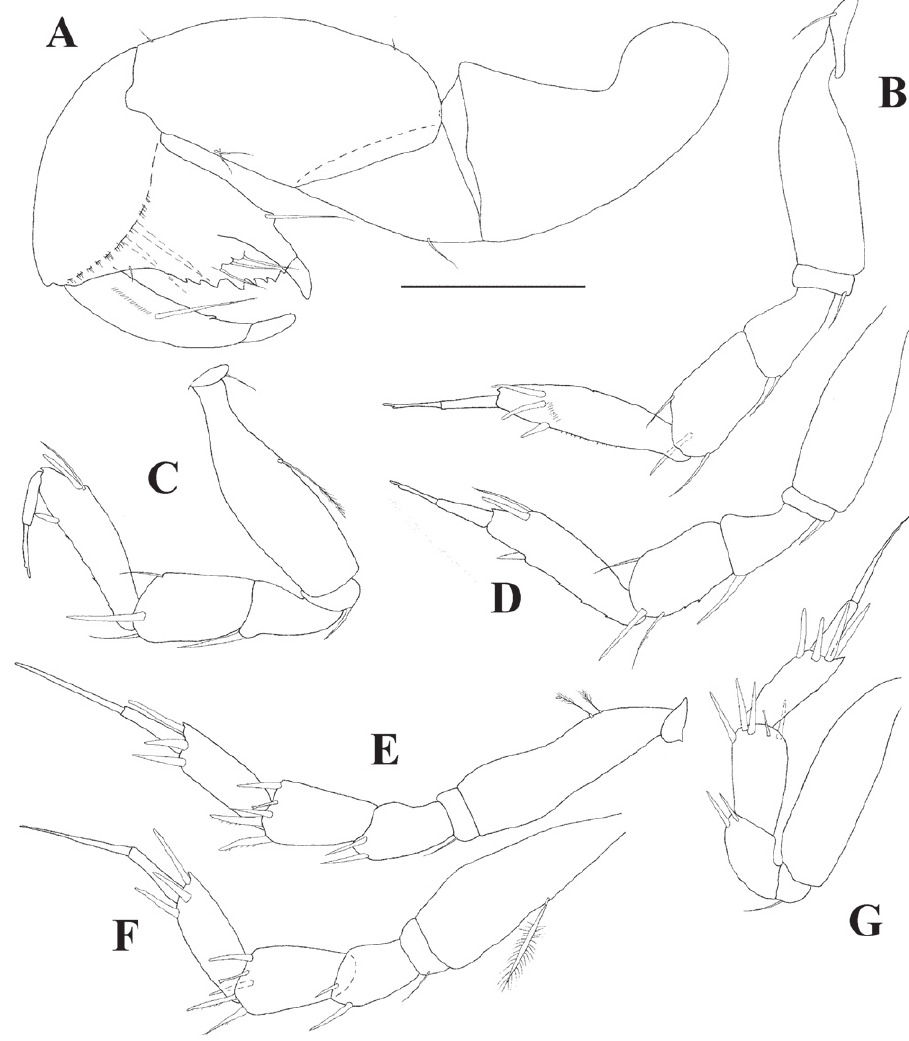
Figure 3. Collettea longisetosa sp. n ., male. Holotype A cheliped B pereopod 1 C pereopod 2 D pereopod 3 E Pereopod 4 F pereopod 5 G pereopod 6. Scale bar = 0.1 mm.